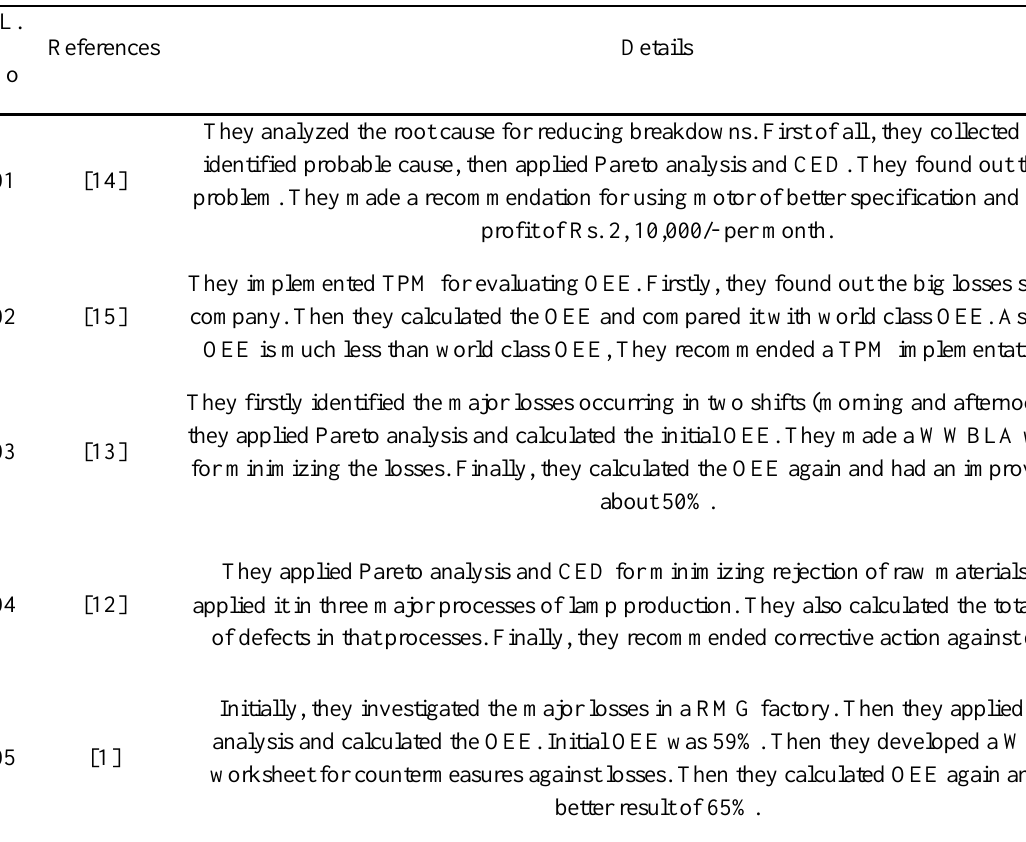
Table. References as reported in the